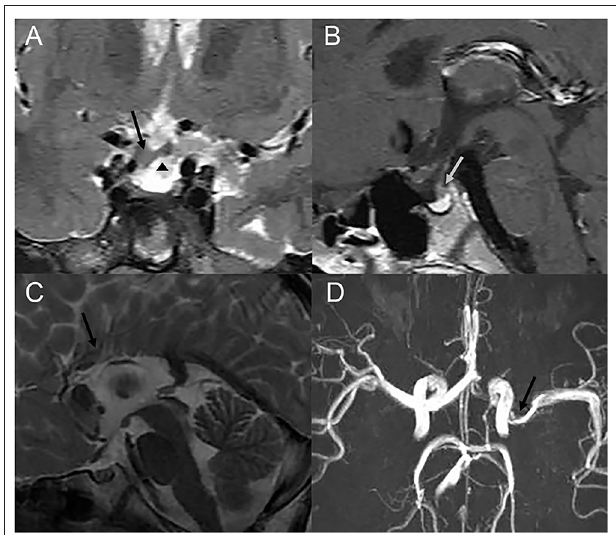
FIGURE 4 | Cranial MRI or MRA images of three patients with cranial abnormalities. (A,B) Coronal T2-weighted and sagittal T1-weighted images of one patient, who showed growth hormone deficiency, showing a thickened optic chiasm (a black arrow), an ectopic pituitary (a triangle), and abnormal pituitary stalk (a grey arrow). (C) Sagittal T2-weighted images of one patient showing the corpus callosum body agenesis. (D) Cranial MRA showing the narrowing of the left M1 MCA segment (an arrow).